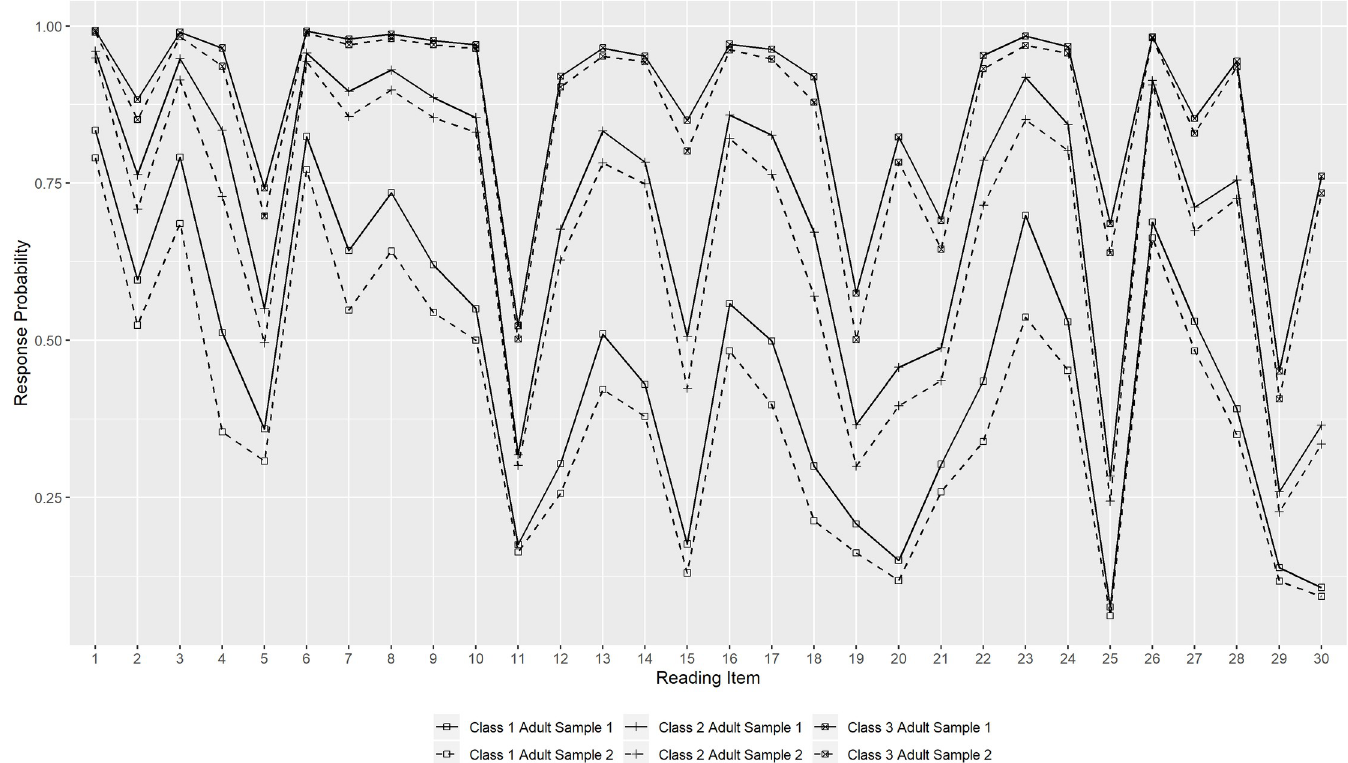
Fig 3. Response probability profile of “correct answer” for 3-class solution among the adult samples.